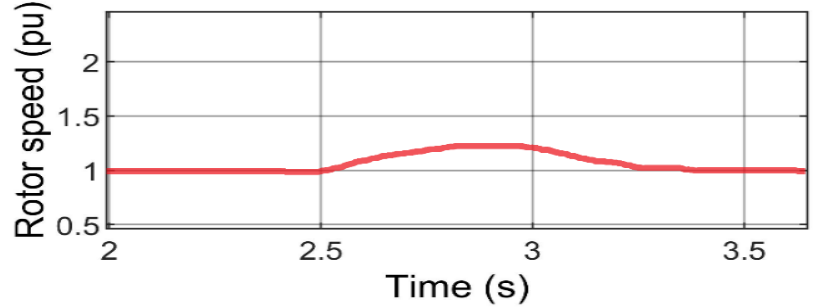
Figure 13. Increased rotor speed during fault.